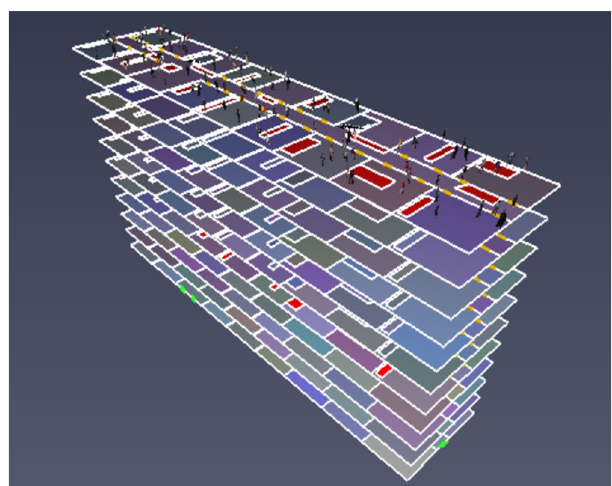
Figure 14. Pathfinder model of safe emergency evacuation.